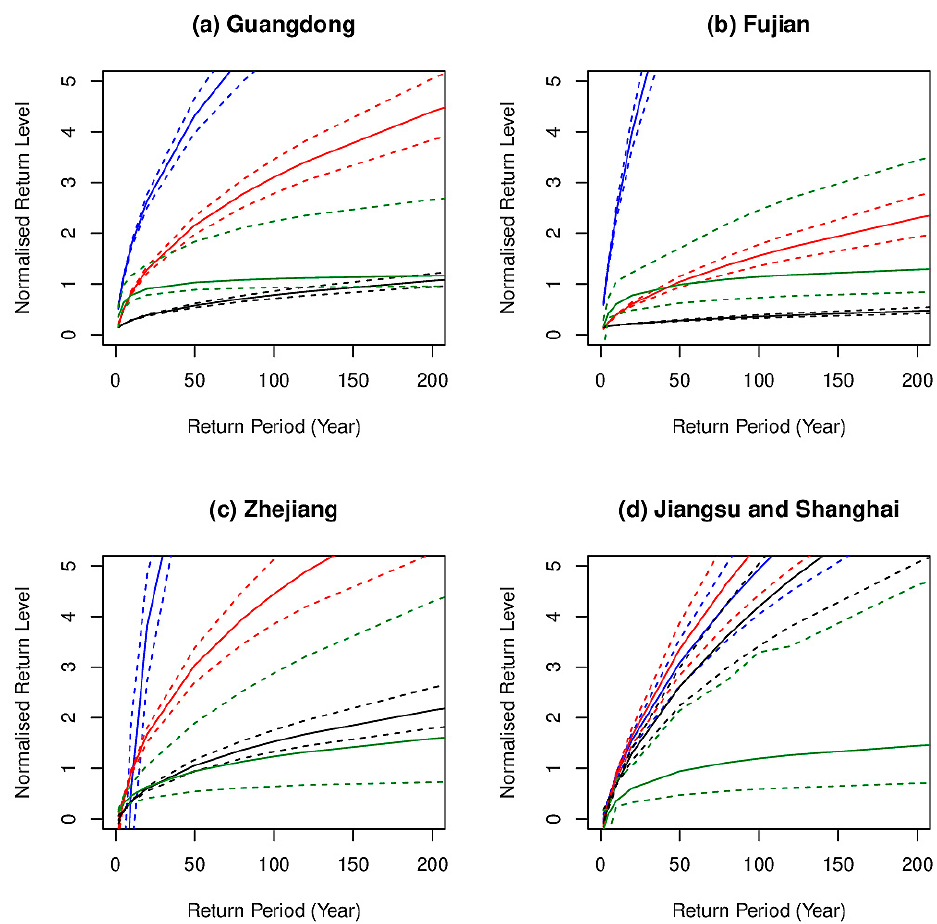
Figure 7. Return period-return level estimation calculated using historical observations (green solid: estimate; green dashed: 95% confidence interval), and using the TOT event set based on the optimistic scenario (black solid: estimate; black dashed: 95% confidence interval), the pessimistic scenario (red solid: estimate, red dashed: 95% confidence interval) and the worst ‐ case scenario (blue solid: estimate, blue dashed: 95% confidence interval). Return level is normalised by the maximum NLoss of the respective regions (see main text).